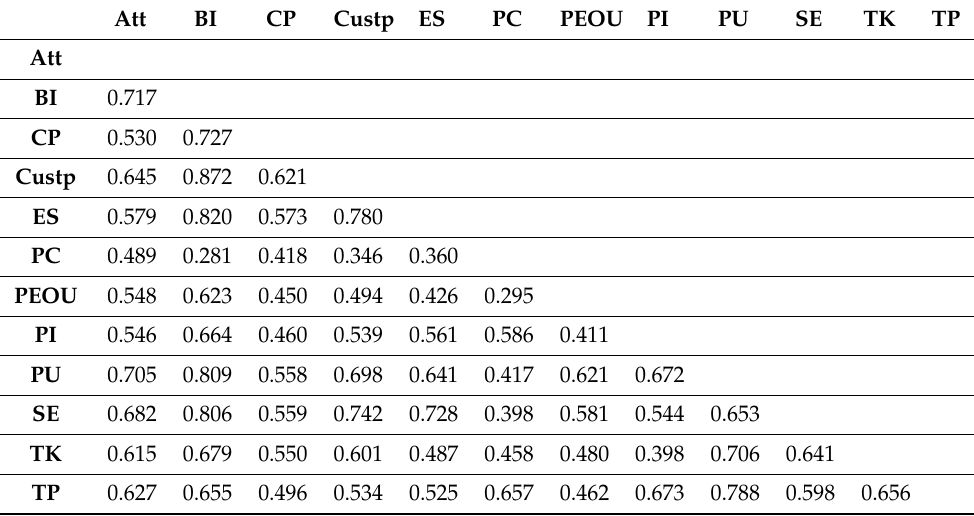
Table 3. Heterotrait-Monotrait ratio (HTMT)